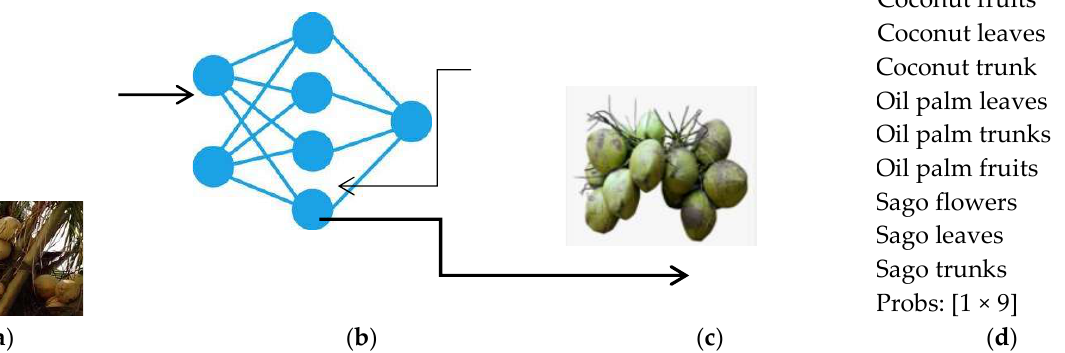
Figure 8. Examples from processing workflow. ( a ) All data trained images. ( b ) Model and optimized parameters via transfer learning. ( c ) Test image cropped (227 × 227) or (224 × 224). ( d ) Classification and probability.